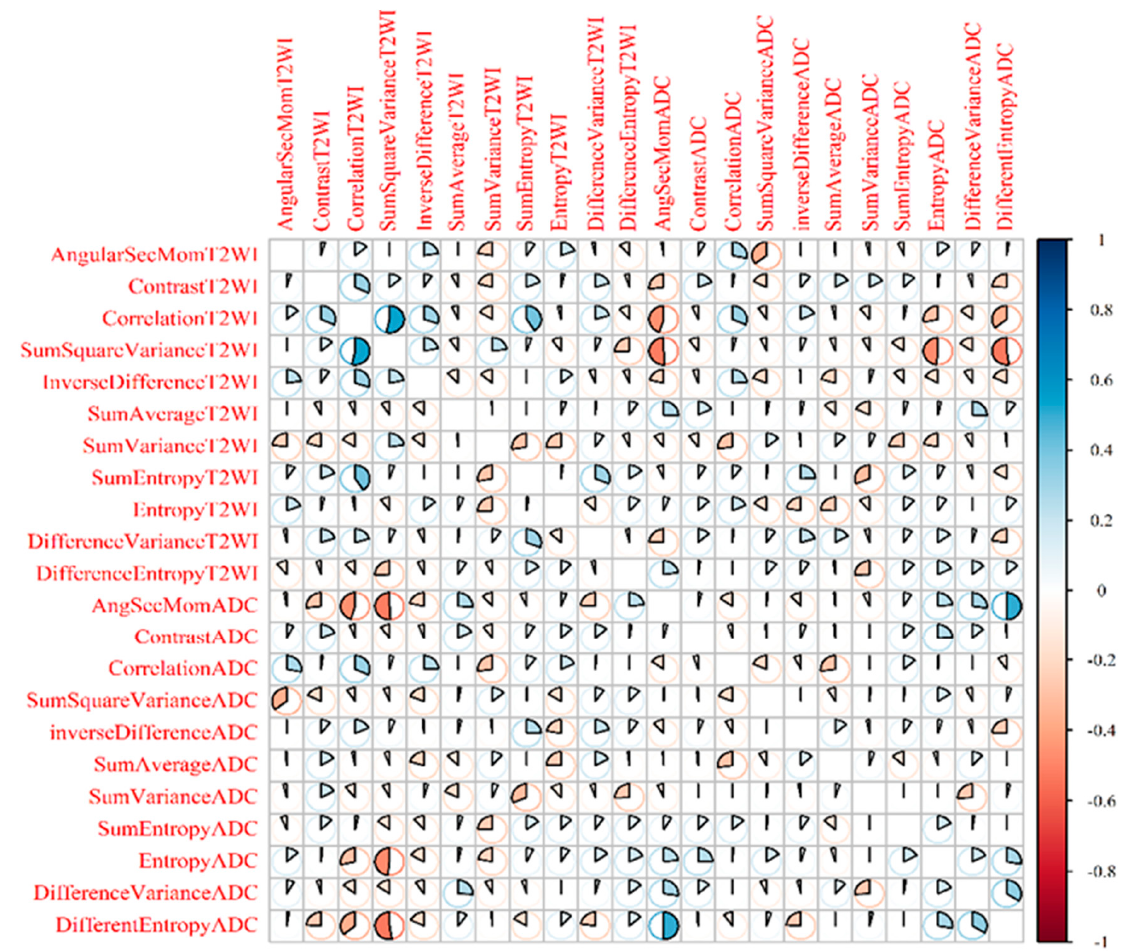
Figure 3. Spearman’s rank correlation between each of the radiomics features and the GS groups. Table 2. Univariate and multivariable logistic regression analysis in predicting significant prostate cancer * (n = 200).